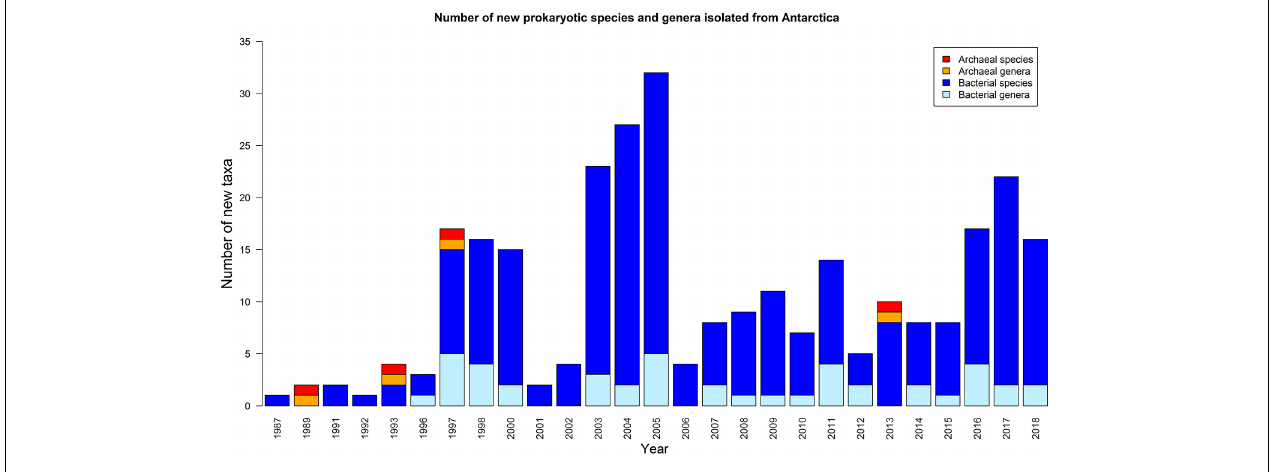
FIGURE 2 | Overview of the number of newly described prokaryotic species and genera isolated from Antarctica based on articles included in Web of Science (up to 16 January